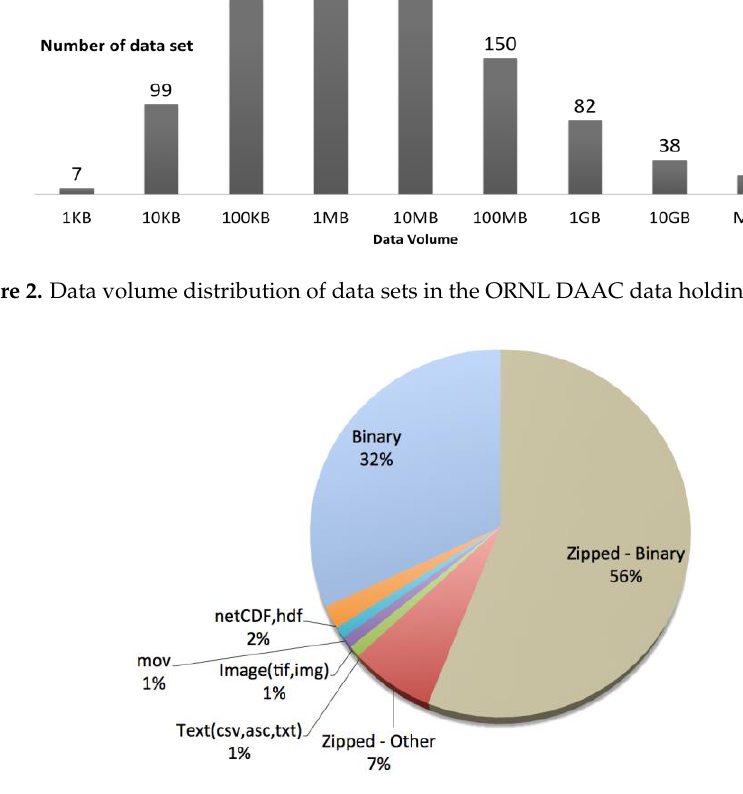
Figure 3. File format of ORNL DAAC data holdings (n = 1126).